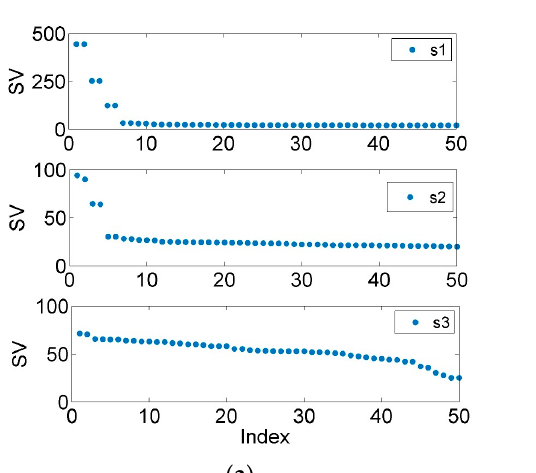
Figure 4. Calculation of simulation signals based on AIC–SVD: ( a ) singular values; ( b ) AIC values. Table 1. Simulation parameters of signals based on AIC–SVD.